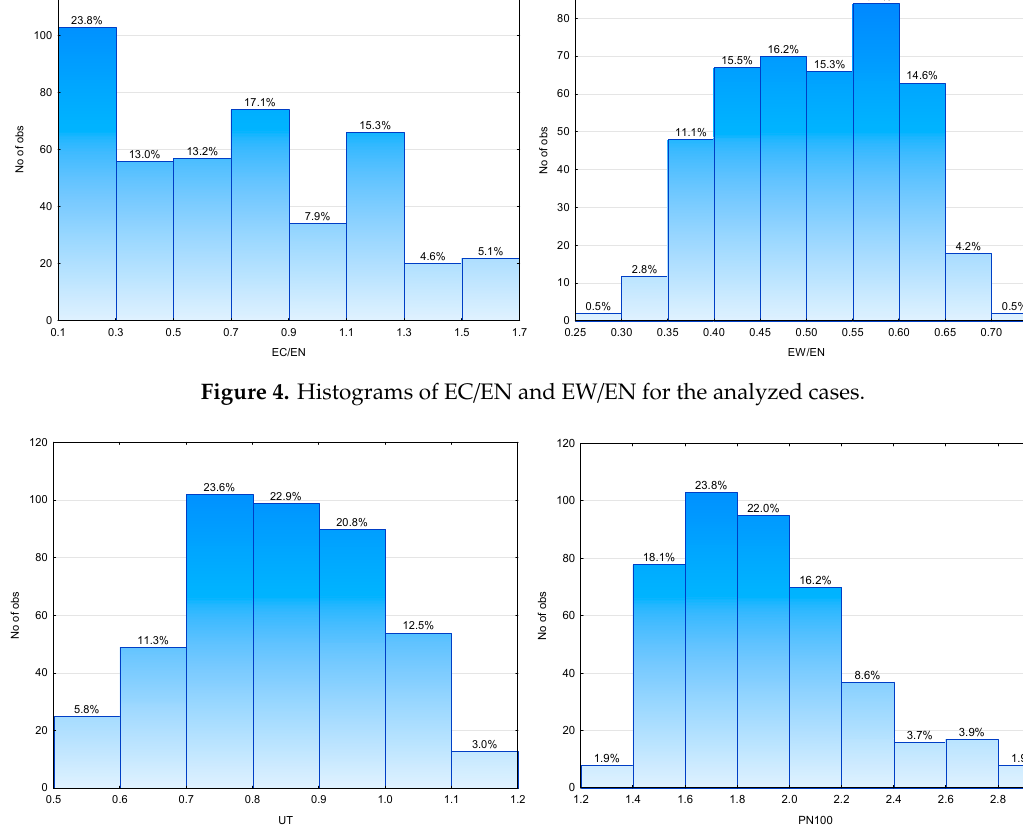
Figure 5. Histograms of UT and PN100 for the analyzed cases.